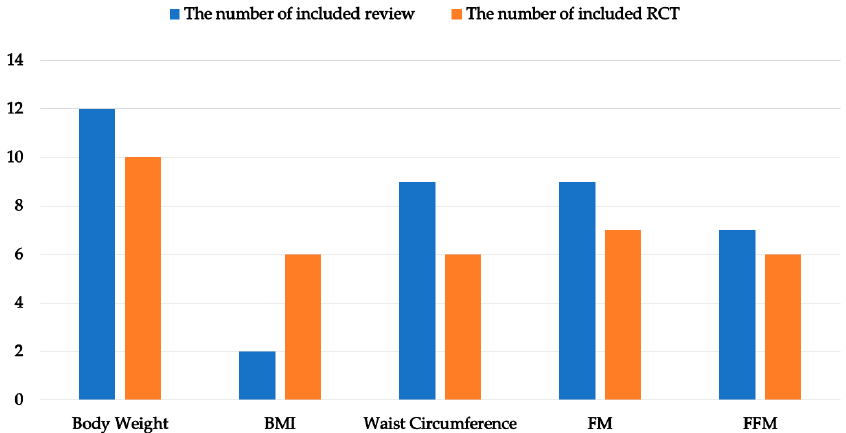
Figure 2. Outcomes for reported data of included reviews and included RCTs. Abbreviations: BMI, body mass index; FM, fat mass; FFM, fat free mass.